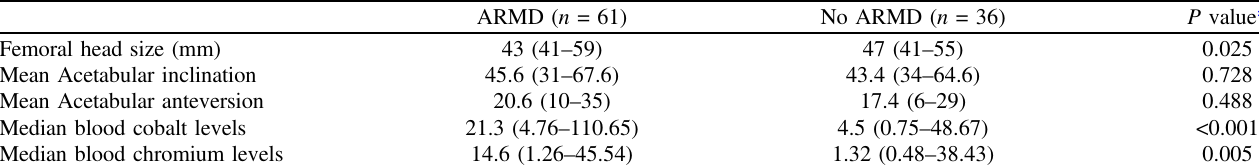
Table 3. Association of ARMD with imaging fi ndings and blood ion levels.